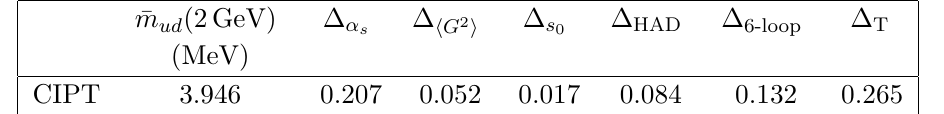
Table 1 . Results for the various uncertainties from CIPT, together with the total uncertainty added in quadrature, (cid:1) T